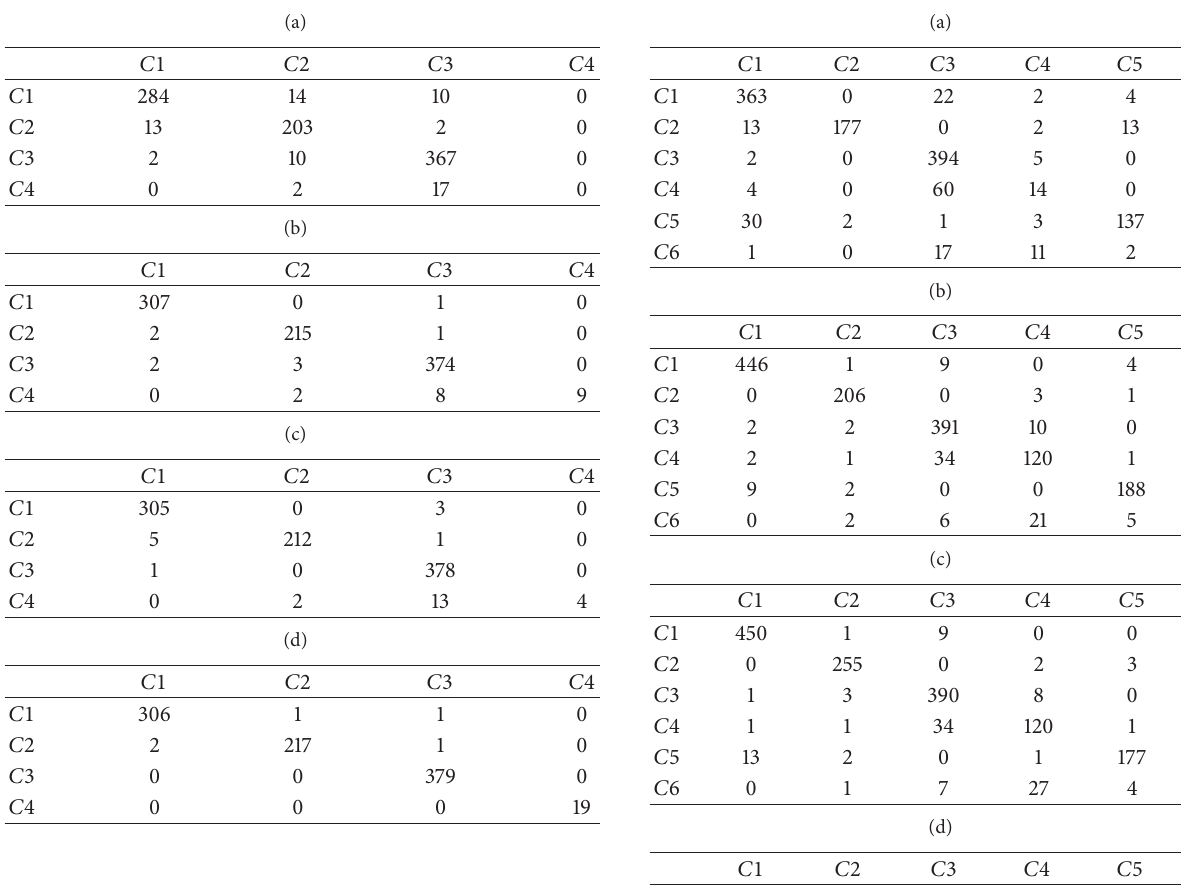
Table 8: Confusion matrices of (a) Adaboost, (b) Bagging, (c) RSM, and (d) proposed approach using Satimage